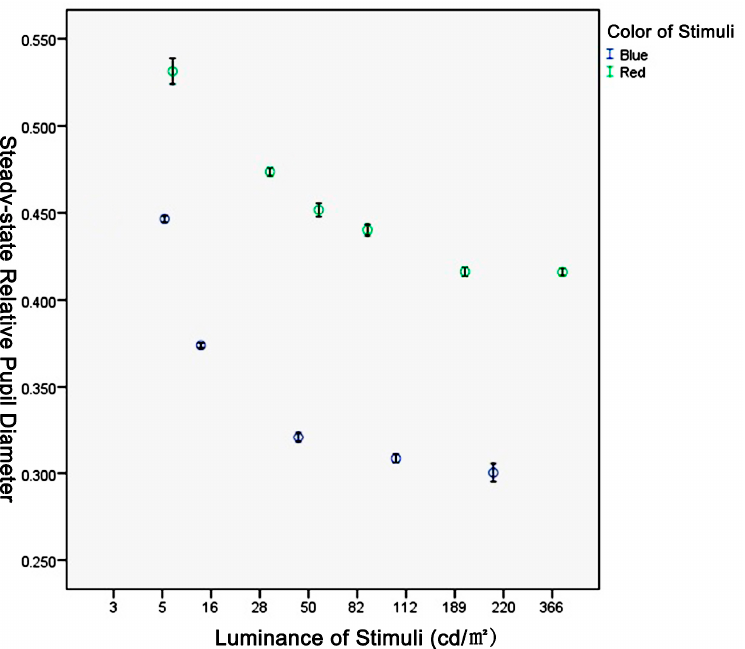
Figure 5. Comparison of steady-state pupil size under different luminance of the red (shown as green circles) and blue stimuli (shown as blue circles). Table 4. Comparisons of steady-state RPDs for the red stimulus with different